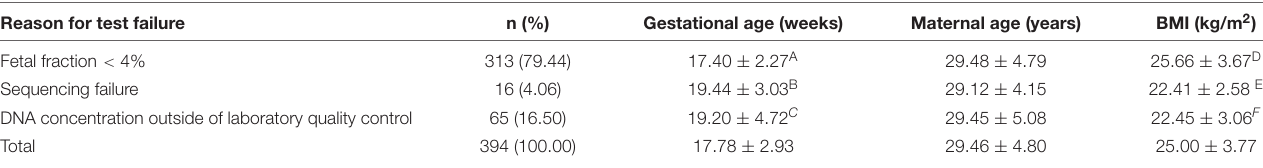
TABLE 1 | The basic characteristics of NIPS test failure